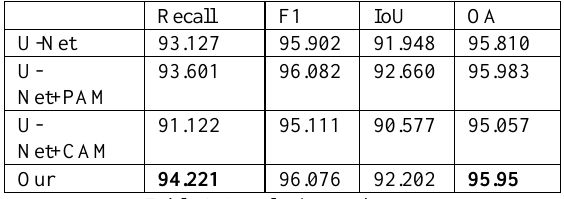
Table 3. Results in test